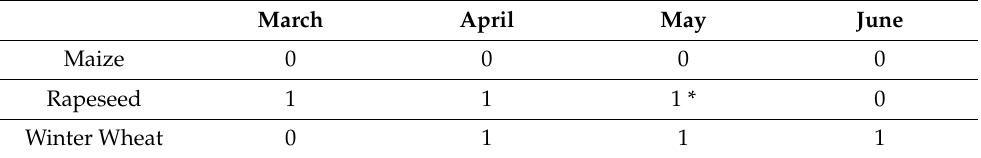
Table 1. Number and timing of insecticide applications in each crop type every